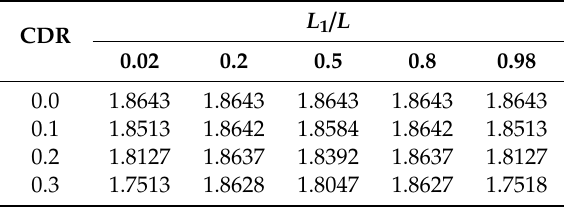
ω ω of cracked FG-X-GPLRC beams with 1 10